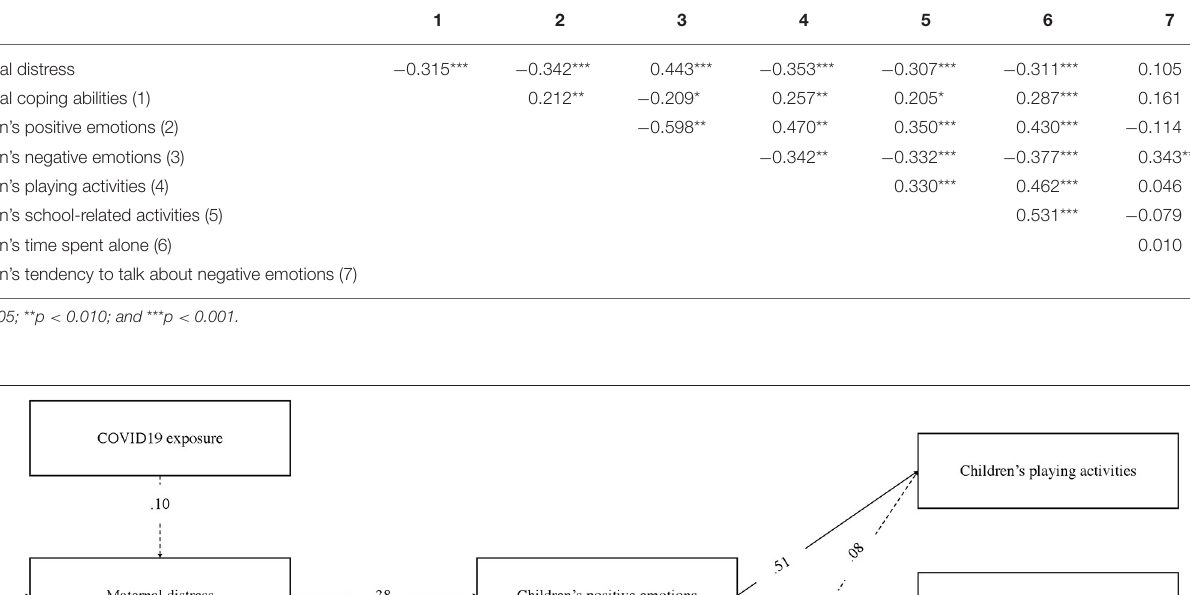
TABLE 2 | Correlation results between variables.